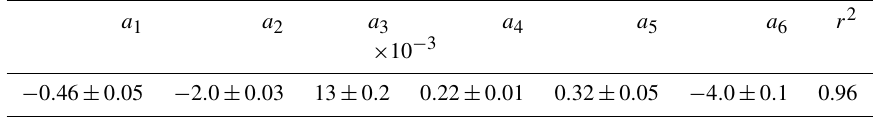
Table 5. The fitting parameters a 1 – a 6 and determination coefficients of Eq. (5) for j (NO 2